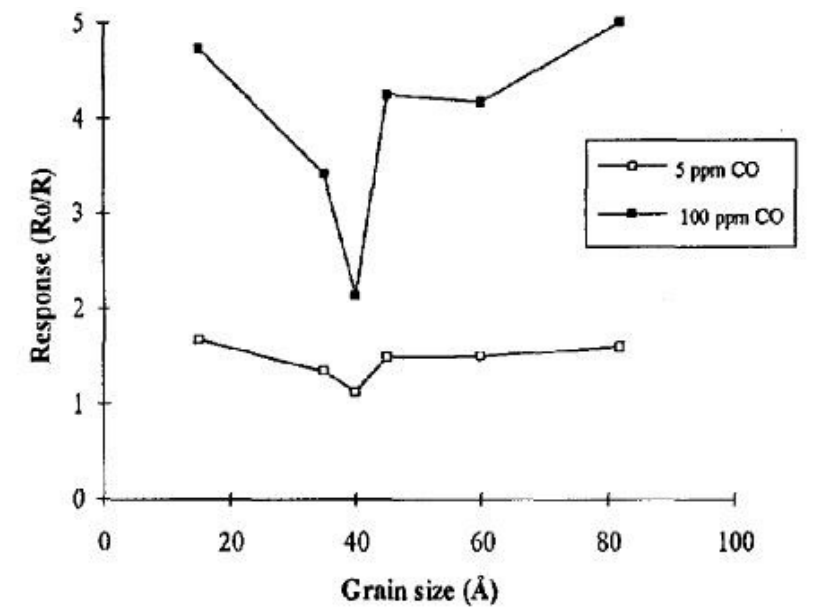
Figure 8. The effect of grain size on the size of response to the carbon monoxide target gas. Figure adapted with permission from